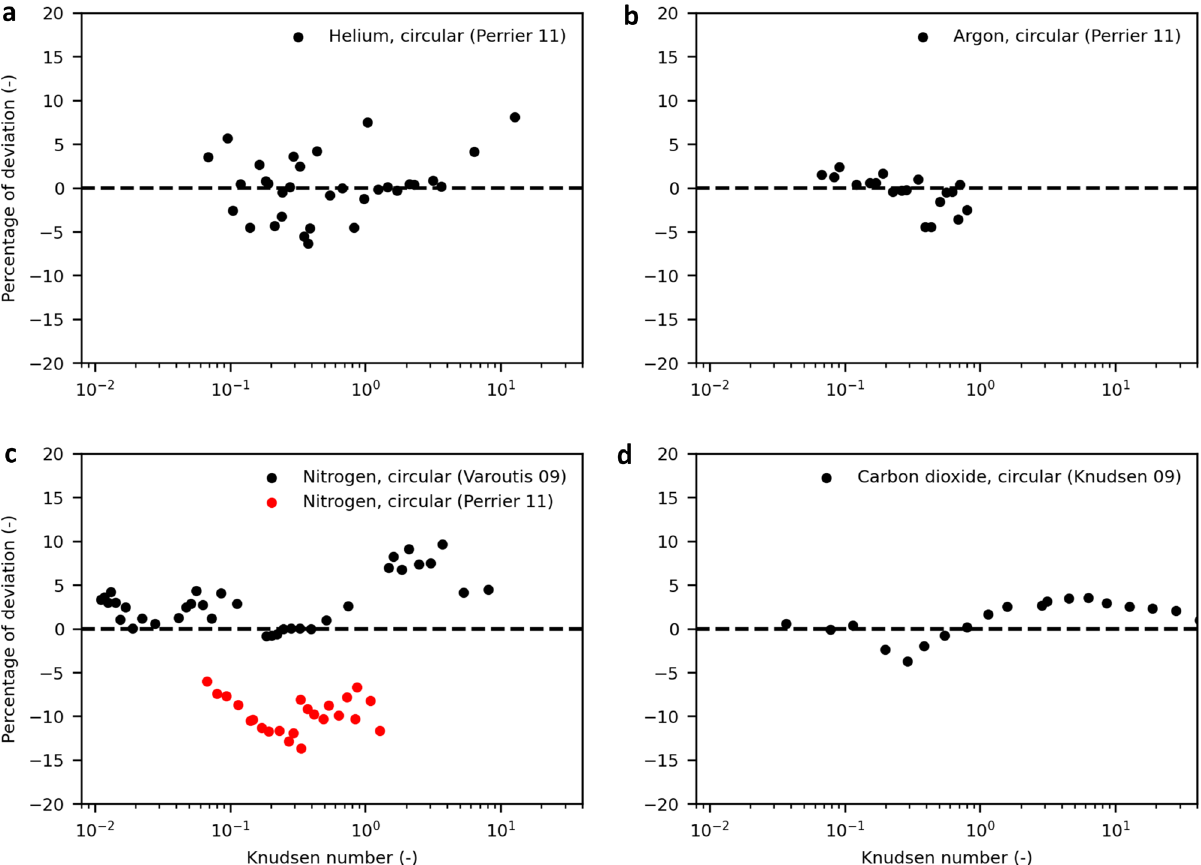
Figure 5. Deviation of modelled mass flow from experimental data for circular channels. The deviation is scattered without any discernible pattern, except for carbon dioxide, a strong indicator that the proposed model explains the experimental data